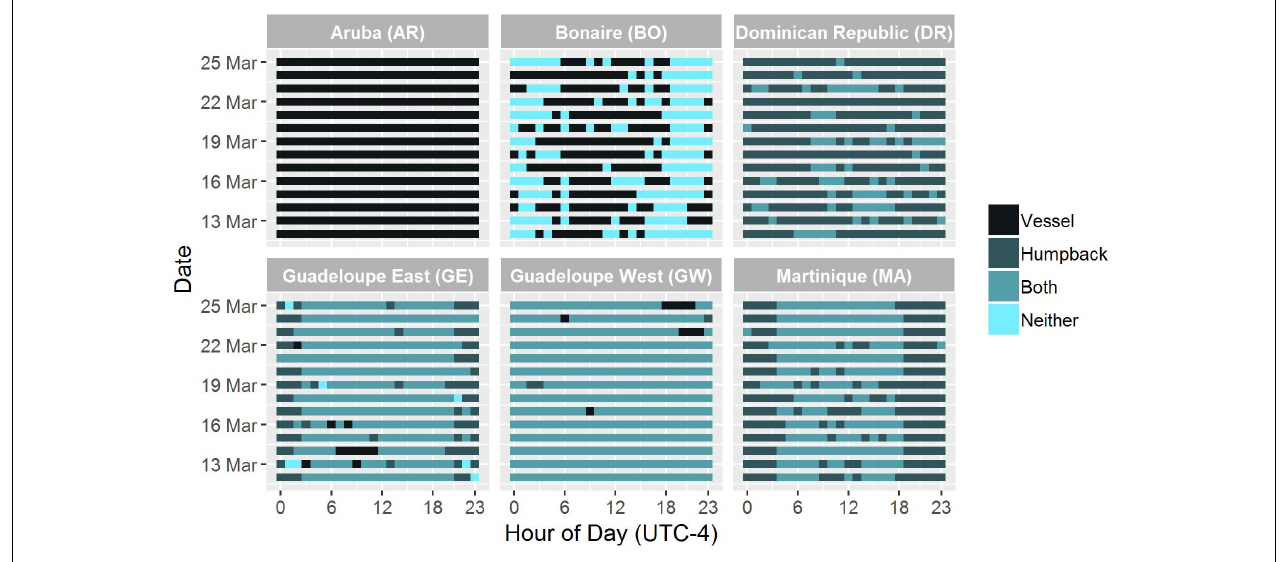
FIGURE 4 | Hourly presence of vessel noise, humpback whale song, both or neither at each recording site from 12 March 2017 to 25 March 2017.